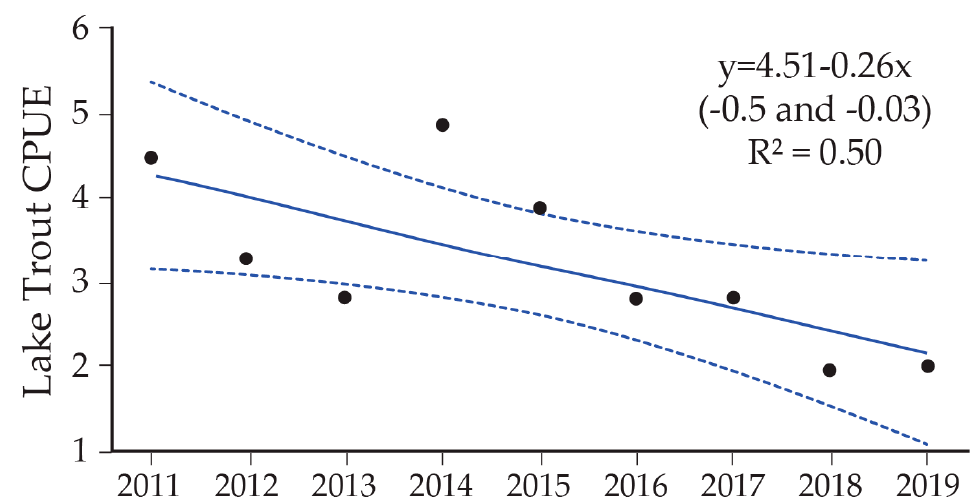
Figure 8. Catch-per-unit-effort (CPUE) of lake trout during annual long-term gillnetting assessments on Yellowstone Lake, 2011–2019. The blue line represents a simple linear regression model with 95% confidence intervals (dashed lines). Numbers within parentheses are the upper and lower 95% confidence limits of the slope parameter estimate, indicating a temporal decline in the CPUE response variable because the interval does not include zero.